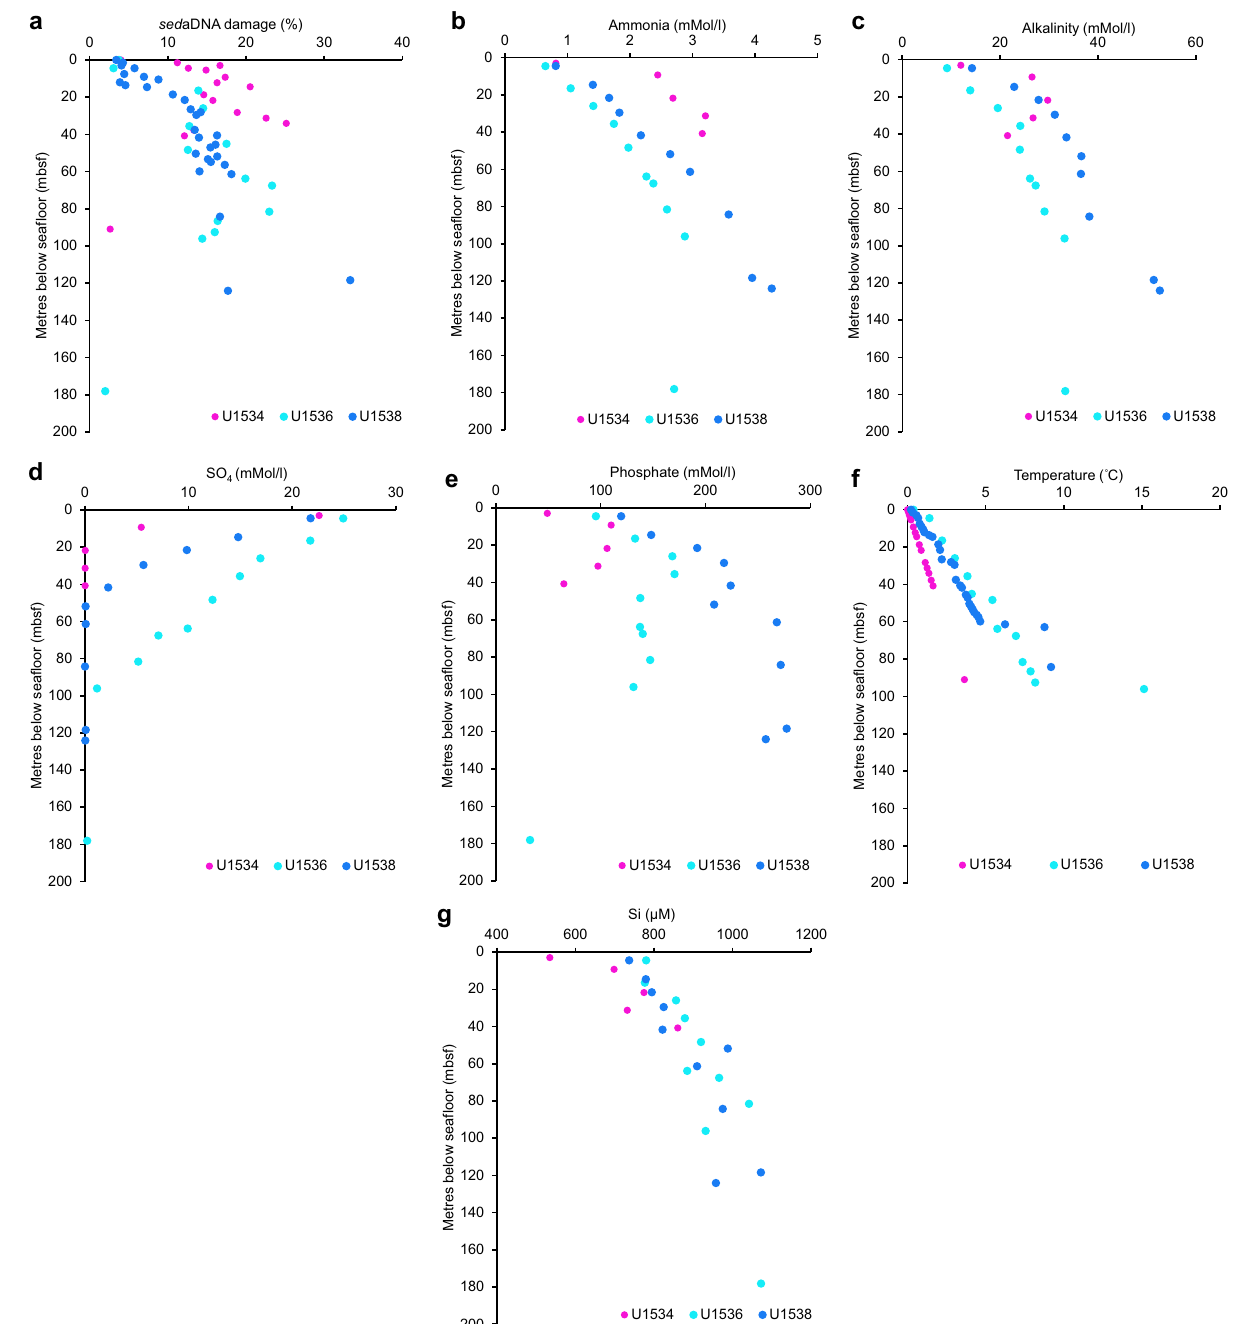
Fig. 6 | Depth pro fi les of eukaryote sed aDNA damage and geochemical para- meters. Plotted against depth (metres below sea fl oor, mbsf) are a the proportion of eukaryote sed aDNA damage (based on SSU+LSU alignments), and all geo- chemical parameters that showed positive correlations with the proportion of